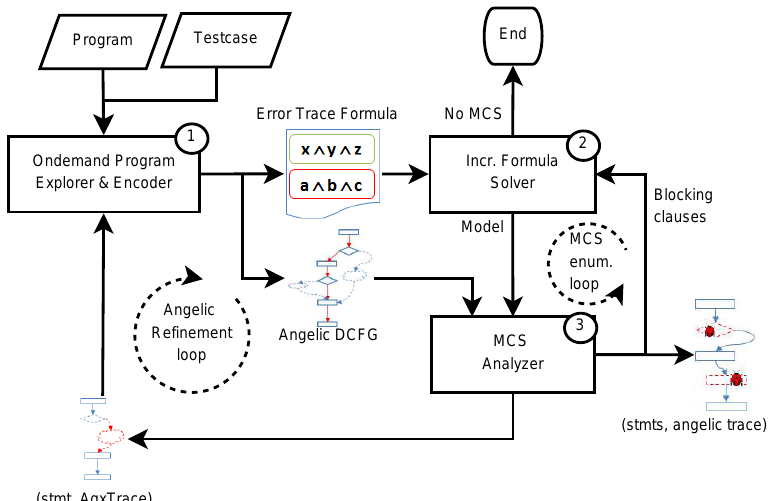
Figure 4. Overview of